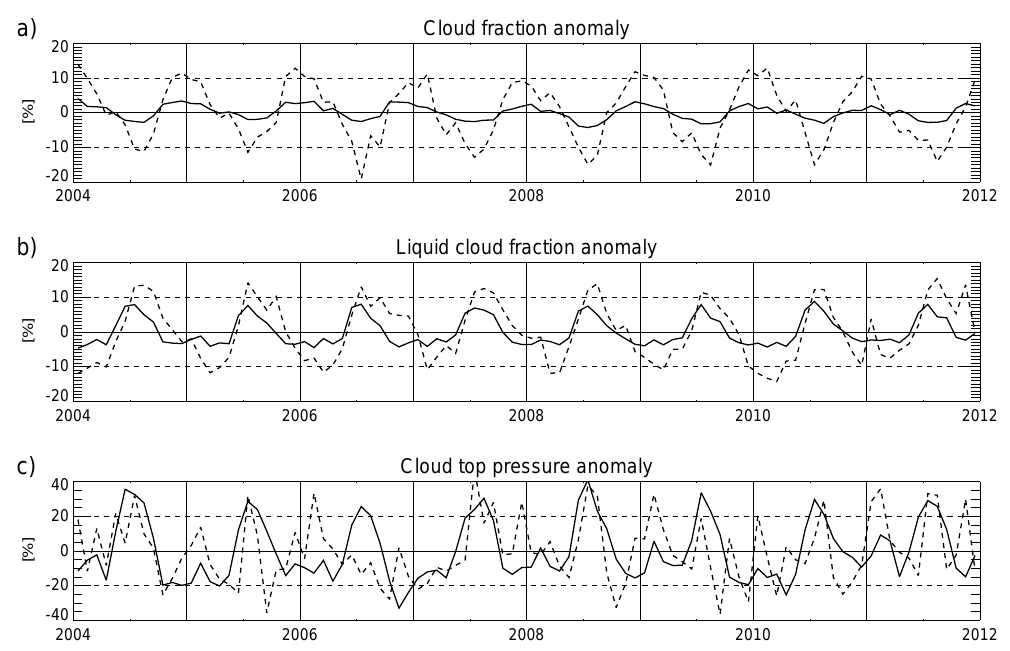
Fig. 7. Time series of CLAAS relative monthly mean anomaly of cloud fraction (a) , liquid cloud fraction (b) and cloud top pressure (c) , averaged over all valid retrievals within the SEVIRI disc (solid lines) and for Europe (dashed